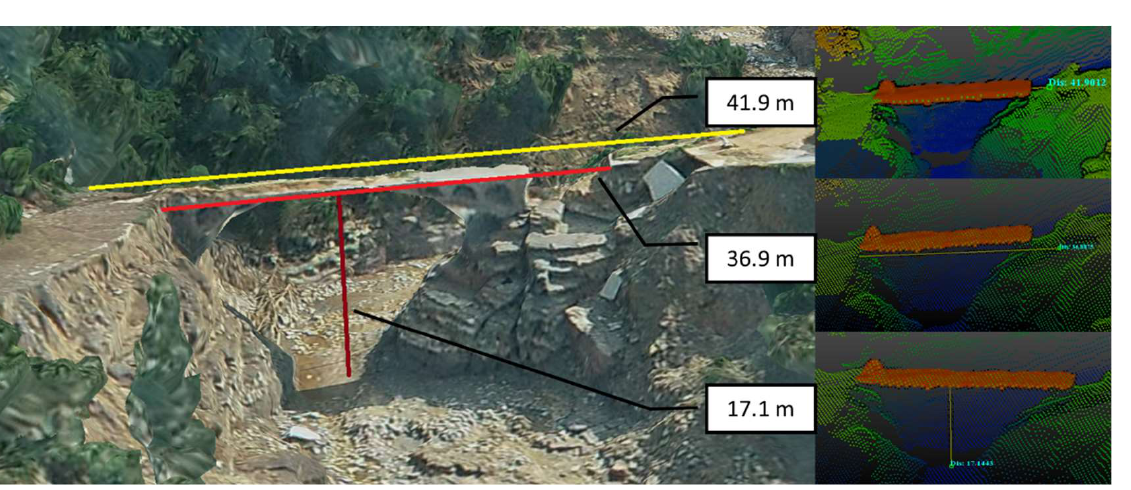
Figure 7. Dam failure site and laser point cloud measurement data.